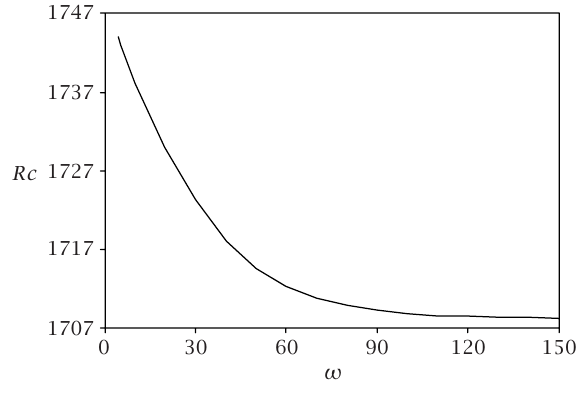
Figure 4.3 . Variation of Rc with ω : P = 1 . 0, ε = 0 . 1, and a = 3 . 1168.